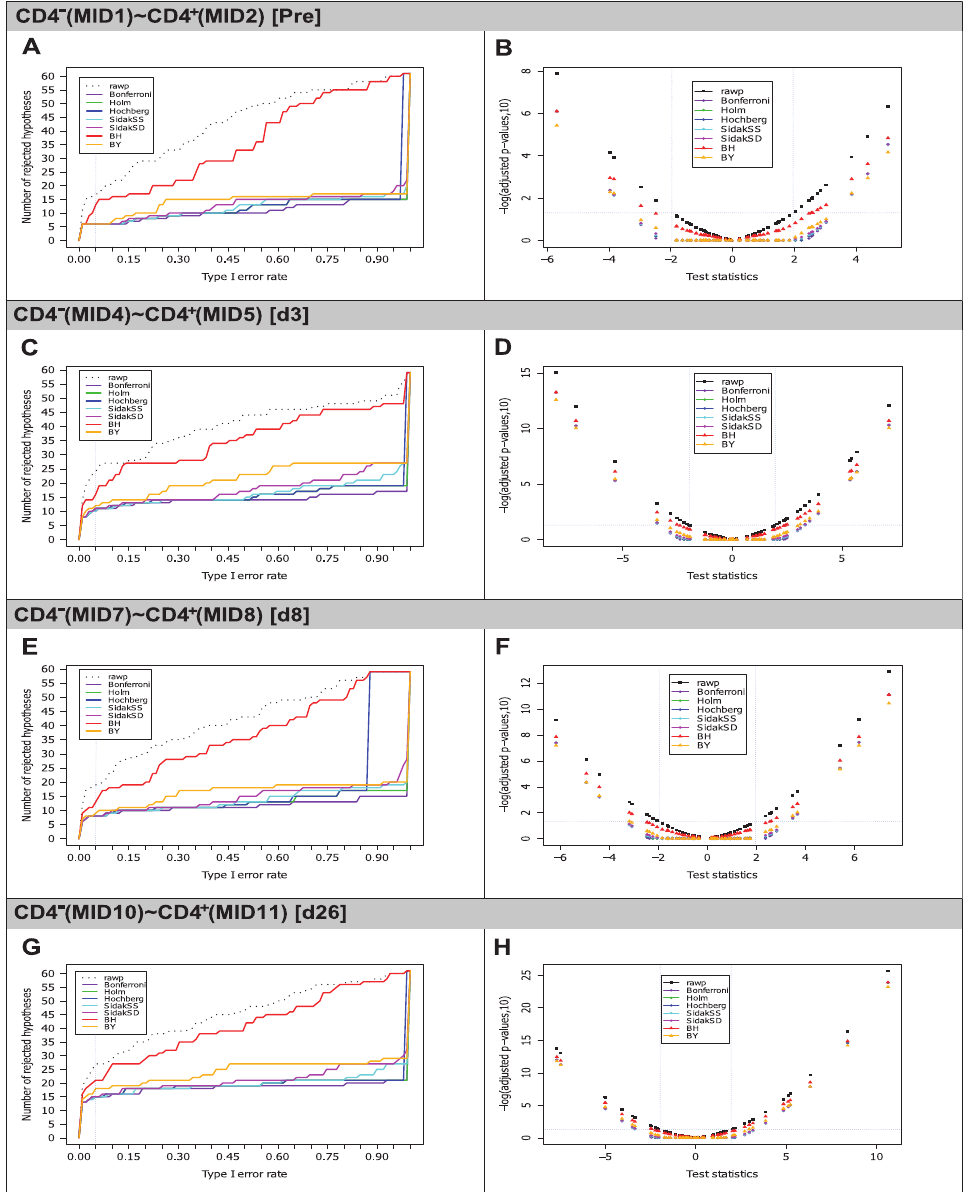
Fig 2. Multiple testing procedures visualization plots. Multiple testing procedures visualization plots are displayed for comparison of the differences in proportions for IMGT clonotypes (AA) with a gene of a given group (TRBV, TRBD or TRBJ), between two T cell populations (CD4 - and CD4 + ) at four time points (Pre, d3, d8 and d26). The following procedures: Bonferroni, Holm, Hochberg, Š idákSS and Š idákSD, BH and BY were applied. Left panel (A, C, E, G): Line graphs showing the number of rejected null hypotheses against the Type I error rate. Dotted lines represent unadjusted p -values (rawp) whereas colored lines represent ajusted p -values of the seven procedures. A vertical line corresponds to a Type I error rate ( α -level) at 0.05 (significance level of 5%). Right panel (B, D, F, H): Negative decimal logarithms (-log 10 ) of unadjusted p -values (black symbols) and adjusted p -values (colored symbols) against the test statistic z -scores. Two areas in scatter plots (top left and top right) correspond to significant differences in proportions and they are delimited at a significance level of 5% (0.05) by -log 10 ( p -values) > 1.3 (horizontal line) and by z -scores ( < -1.96 for negative differences or > 1.96 for positive differences) (vertical